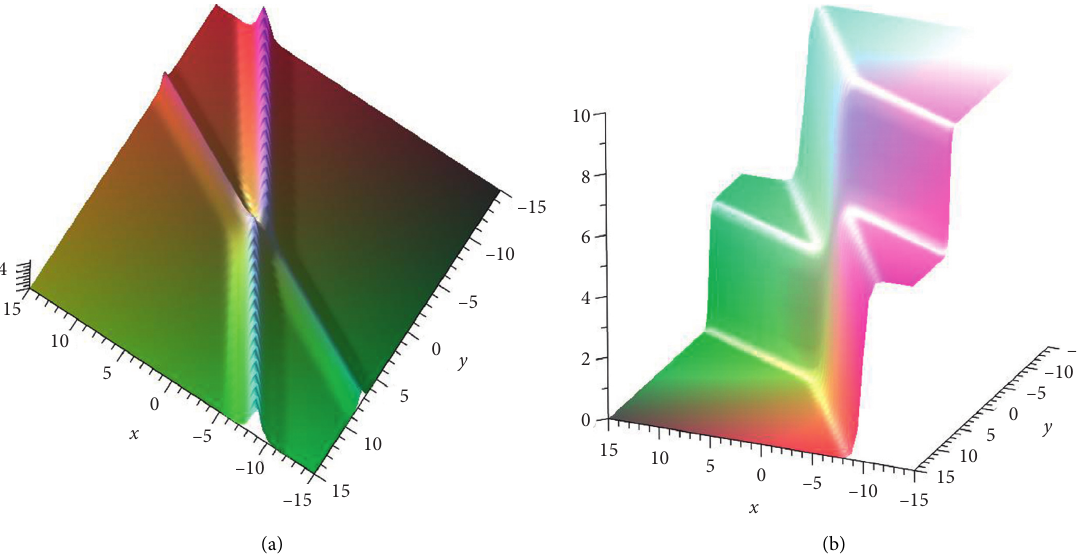
� 2 , b � 4 , a � 3 , b � 2 , δ � 1 , δ � − 1 , η � 0 , 1 1 2 2 1 2 01